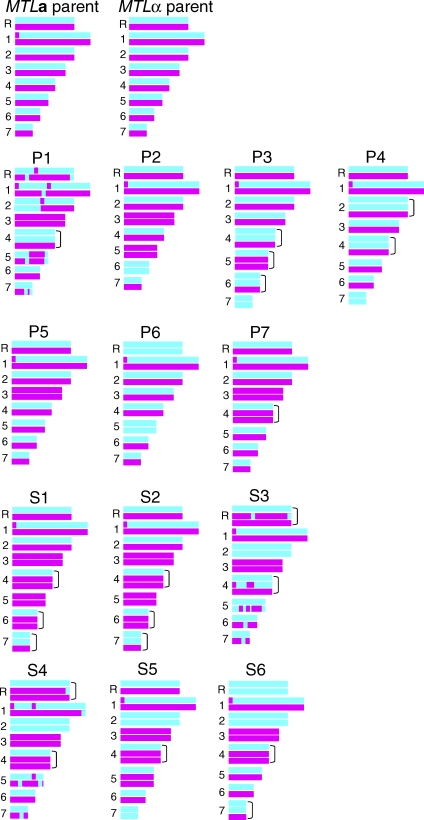
Schematic Summary of Genomic Profiles of Progeny Strains Derived from Tetraploid Strains via the Parasexual CycleProgeny strains were analyzed by SNP and CGH whole-genome microarrays to determine the copy number of each chromosome and the configuration of chromosome homologues. Chromosome homologues are indicated by blue and pink bars to represent “maternal” and “paternal” homologues, respectively. Genetic recombination events are indicated by loss of heterogeneity between chromosome homologues. In cases where the chromosome is trisomic, this is indicated by a bracket to the right of the trisomic chromosome. P1 to P7 progeny strains were derived from growth of the tetraploid RBY18 strain on pre-spo medium, while S1 to S6 strains were derived from tetraploid growth on sorbose medium. Detailed SNP and CGH array data is provided in Table S4 and Figure S4.